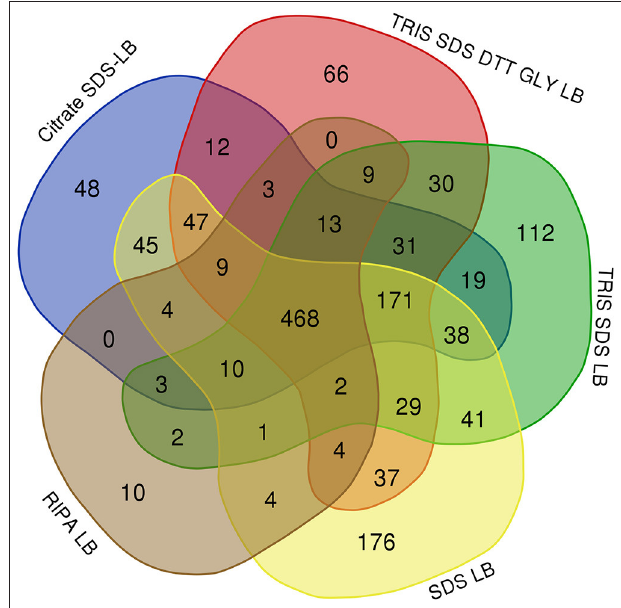
FIGURE 5 | Venn diagram showing the number of common and unique proteins identified after using the different SDS-containing buffers for the extraction of proteins from FFPE kidney tissue samples: buffer 1 (Tris-SDS LB), buffer 3 (Tris-SDS-DTT-Glycerol LB), buffer 4 (citrate-SDS LB), buffer 5 (SDS-LB), and buffer 6 (RIPA